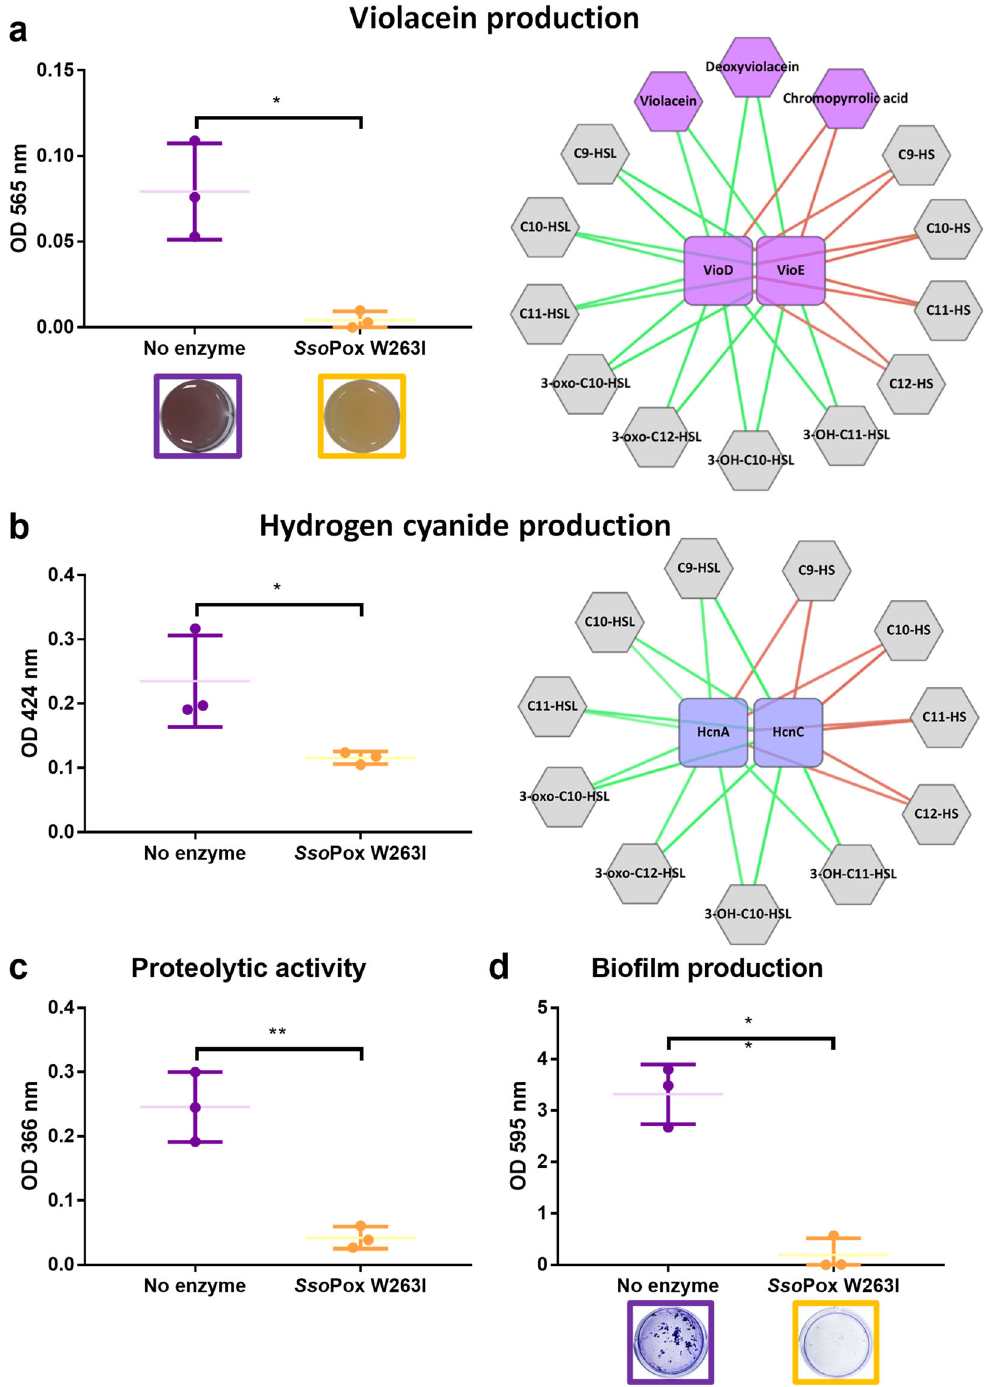
Fig. 5 Sso Pox W263I inhibits QS-regulated factors production of C. violaceum . Mean levels of violacein ( a ) hydrogen cyanide ( b ), protease ( c ), and bio fi lm ( d ) production of C. violaceum untreated (purple) and treated cultures with 0.5 mg ml − 1 Sso Pox W263I (yellow). Error bars represent the standard deviations of n = 3 biological replicates (each represented by one point). * P values <0.05; ** P values <0.01 according to Student ’ s t test. Representative pictures of untreated (yellow squares) and lactonase treated cultures (yellow squares) ( a ) and their bio fi lm formation after coloration with crystal violet ( d ) are given. Network represents correlation multi-omics networks where proteins (squares) and metabolites (hexagons) involved in violacein ( a ) and hydrogen cyanide production ( b ) production and signi fi cantly impacted by Sso Pox W263I are positively (green) or negatively (red)